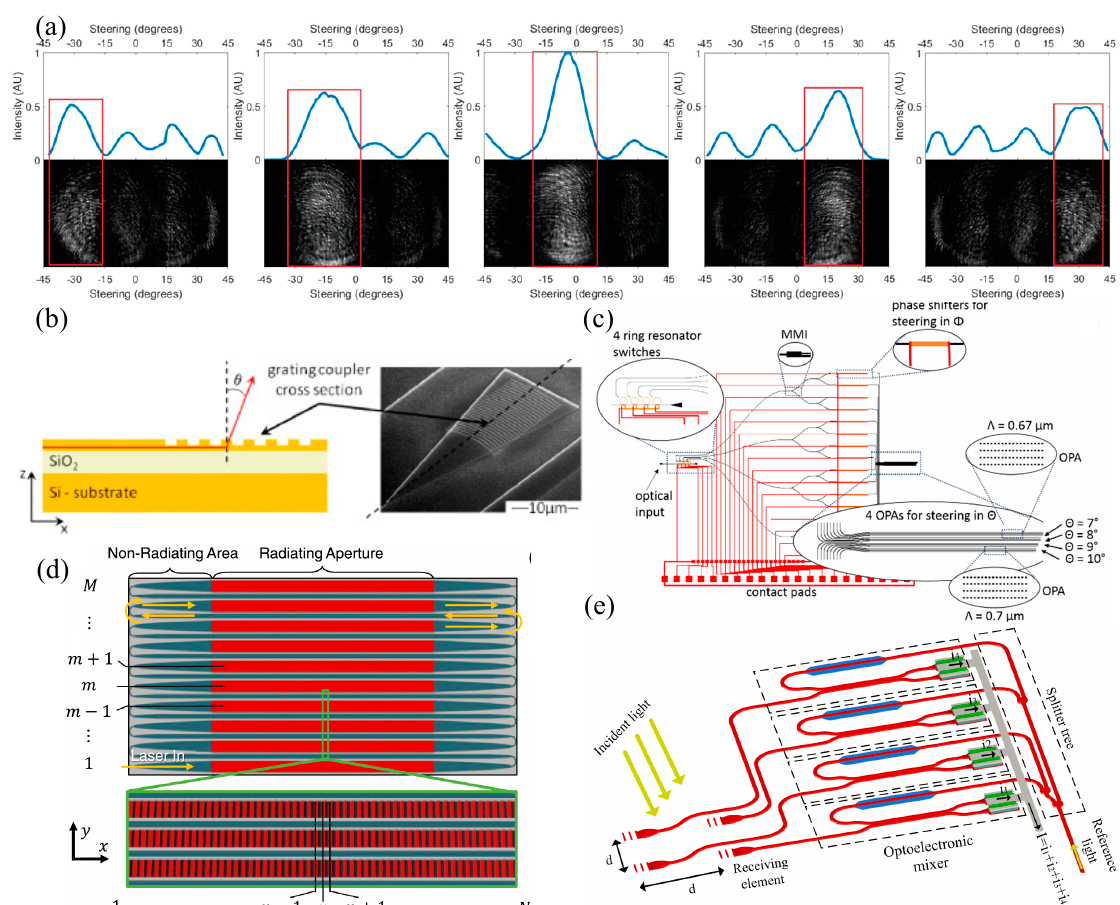
Figure 3. ( a ) Half-wavelength element spacing OPA with integrated TO heaters for beam steering from left to right. Reproduced from [61] with the permission of AIP Publishing. ( b ) Schematic view of the cross section of a WGA. Reprinted with permission from [8] © The Optical Society. ( c ) Schematic image of the proposed 2D beam steering device at a fixed wavelength. Reprinted with permission from [62] © The Optical Society. ( d ) Schematic of a serpentine OPA. Reprinted with permission from [63] © The Optical Society. ( e ) A 2 × 2 OPA receiver. Reprinted with permission from [43] © The Optical Society.